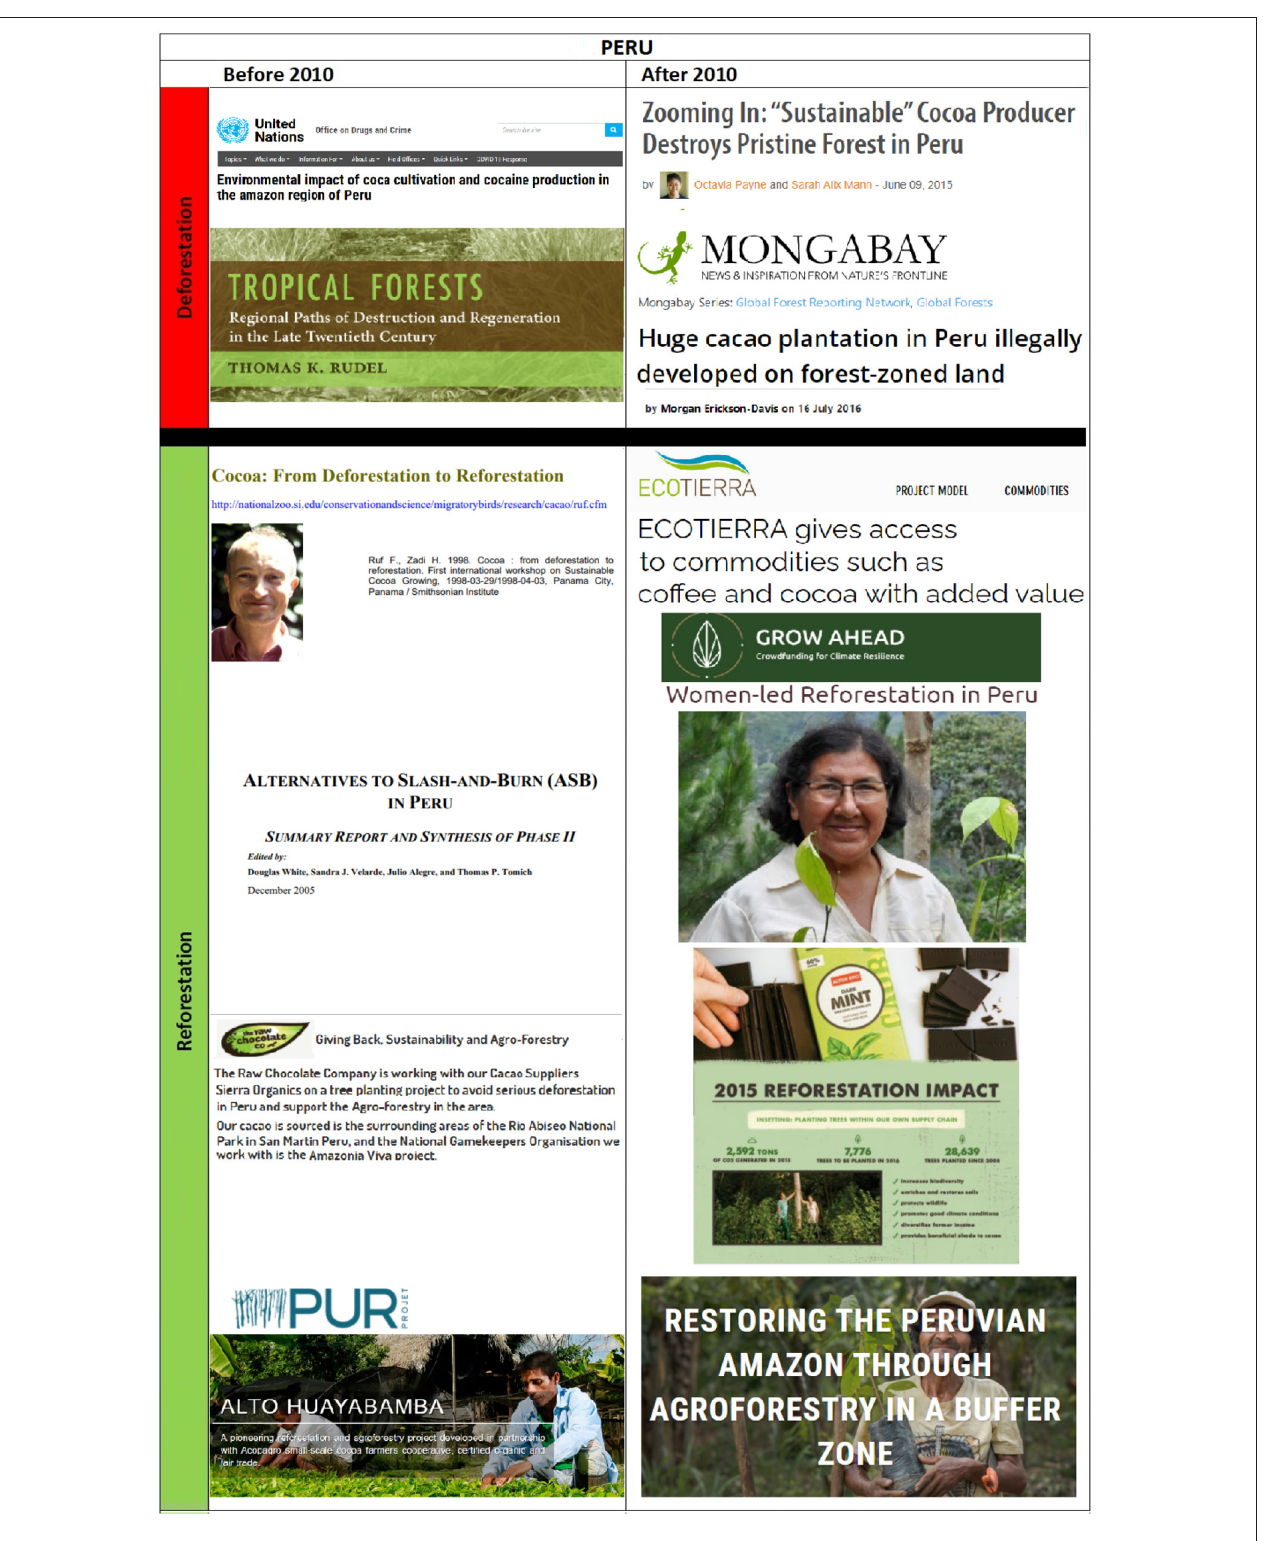
FIGURE 4 | Peru’s media outlook (before and after 2010) linking cocoa cultivation to reforestation and deforestation.